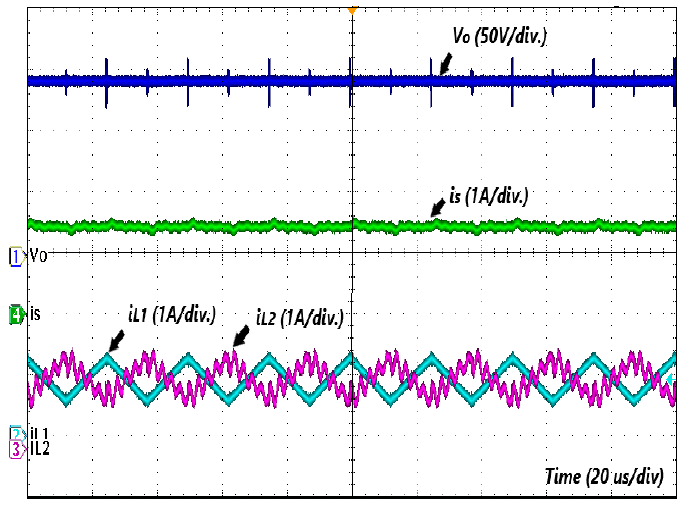
Figure 11. Traditional duty cycle 𝑑 = 0.5.